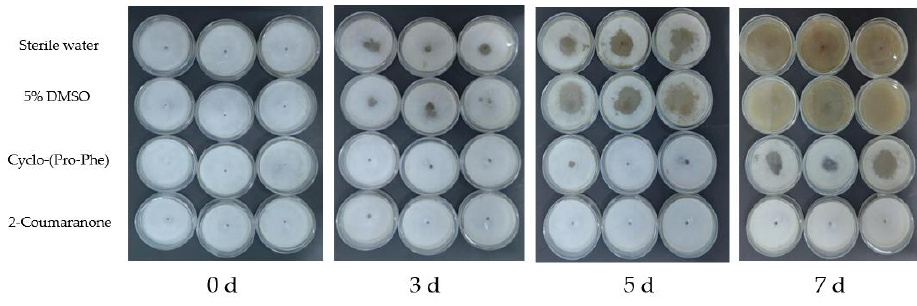
Figure 6. The feeding of Botrytis cinerea in Petri dishes after inoculation with different